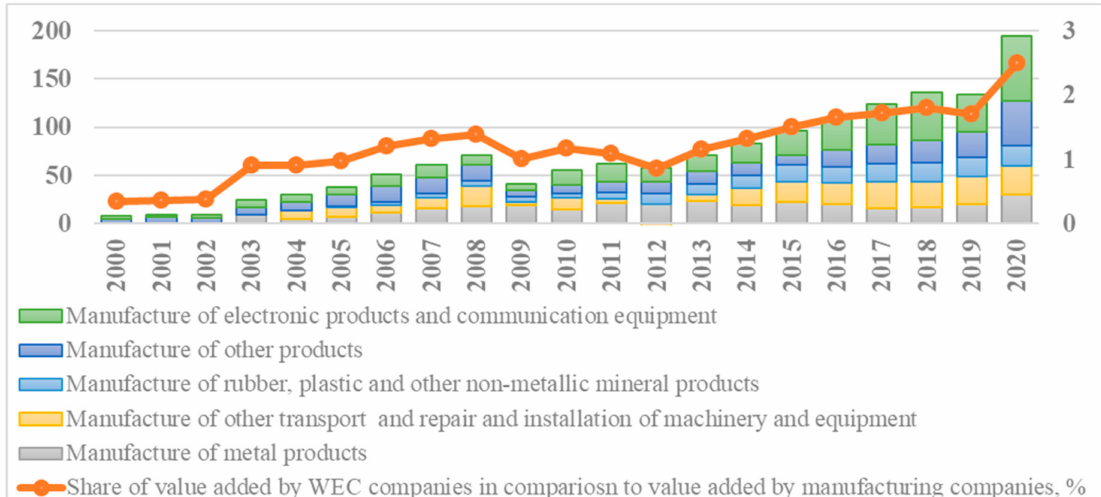
Figure 3. Value added, million EUR (at current